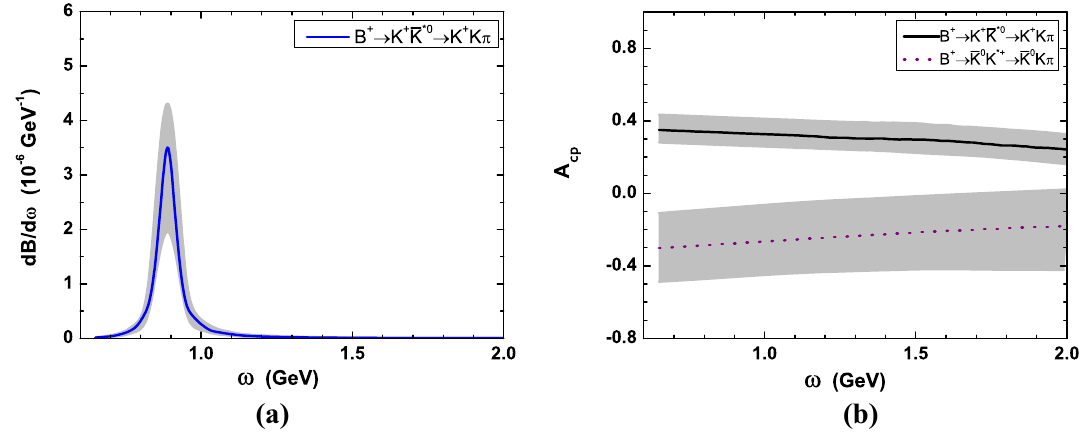
Fig. 1 a Differential branching ratios for the B + → K + ¯ K ∗ 0 → K + K π decays, and b differential distributions of A cp in ω for the decay modes B + → K + ¯ K ∗ 0 → K + K π and B + → ¯ K 0 K ∗+ → ¯ K 0 K π . Shaded bands show the estimated theoretical